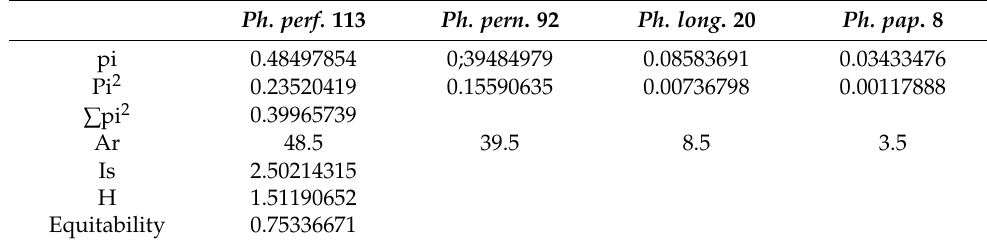
Table 1. Biodiversity indexes and dominant sandflies species in the site of Utique. Ph. perf. 113 Ph. pern . 92